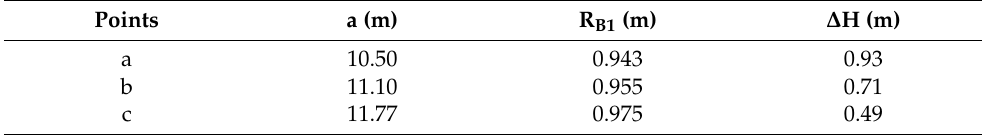
Table 2. Selected representative points at different offsets (R B2 = 0.850 m).